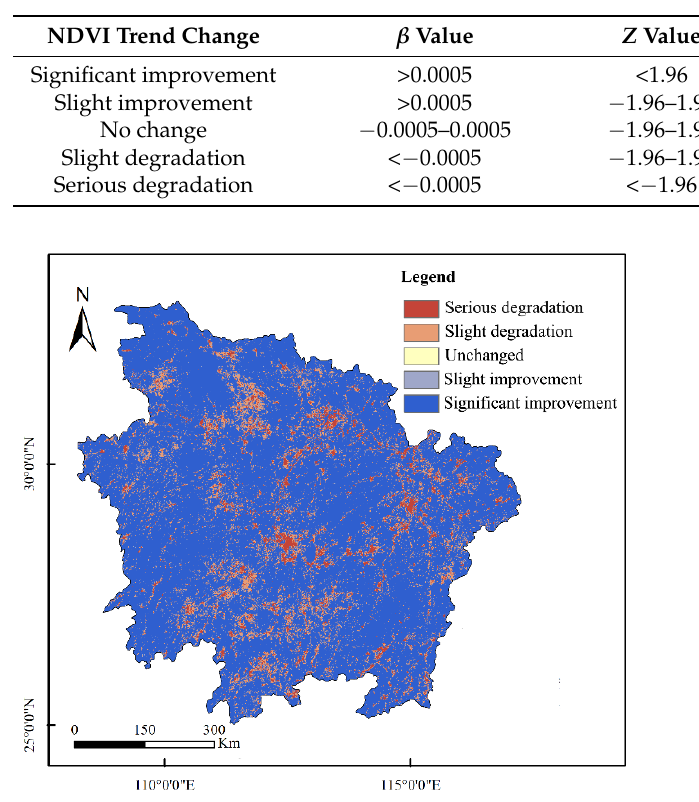
Figure 3. Spatial distribution of average NDVI and pixel distribution in the middle reaches of the Yangtze River (MRYR). Table 2. Trends of vegetation NDVI in the middle reaches of the Yangtze River (MRYR).